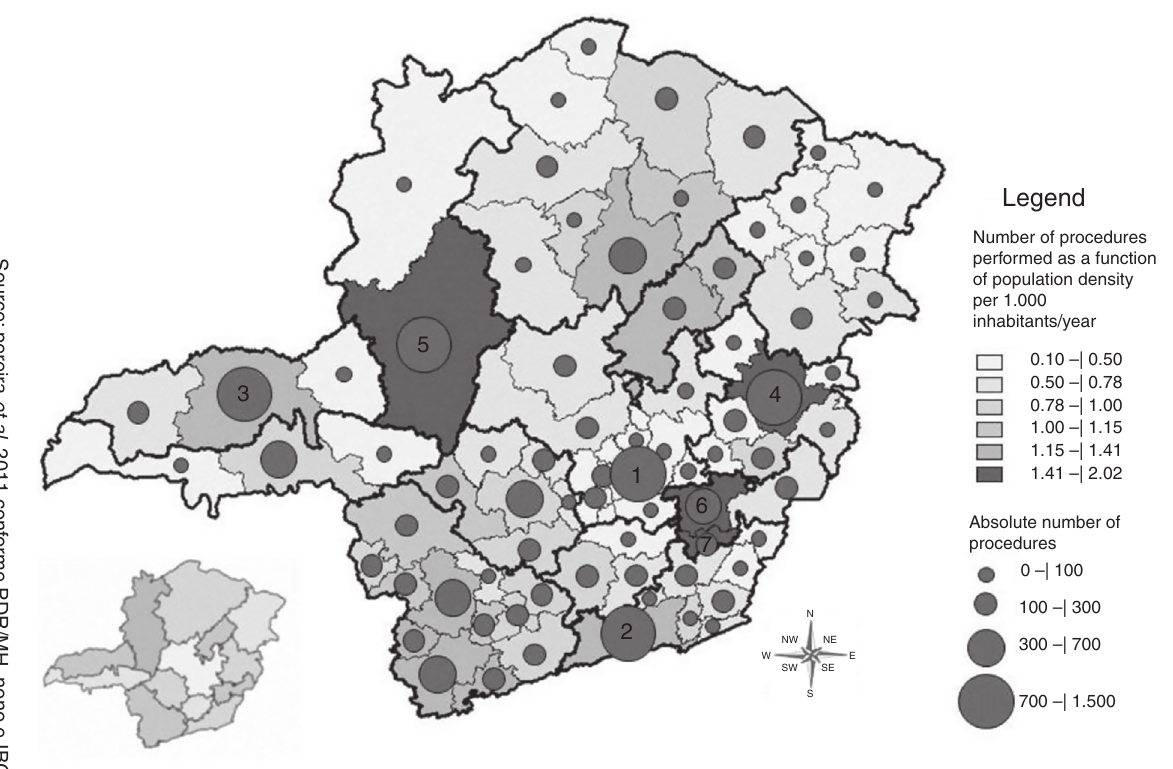
Figure 1 Spatial distribution according to micro- and macro-region of the ‘‘Assessment and Diagnosis’’ procedure per 1000 inhabitants/year and